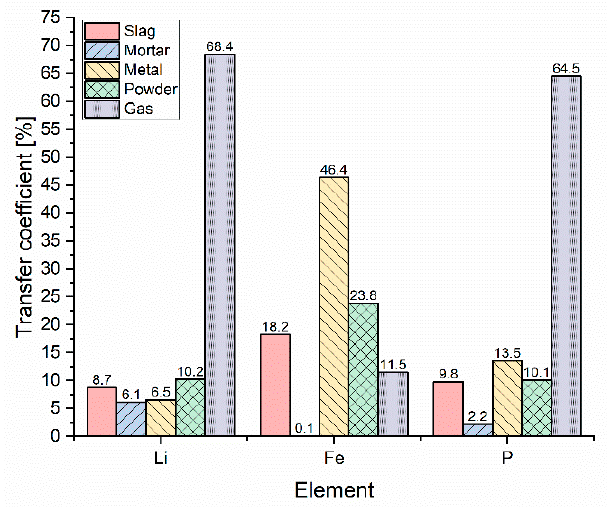
Figure 17. Transfer coefficients of the elements into the individual fractions in % of the experiment in Design 1.